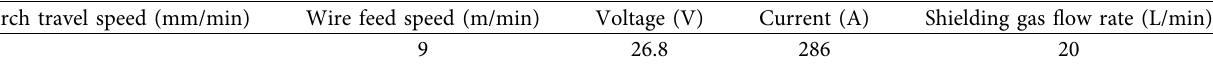
Table 2: Process parameters of the